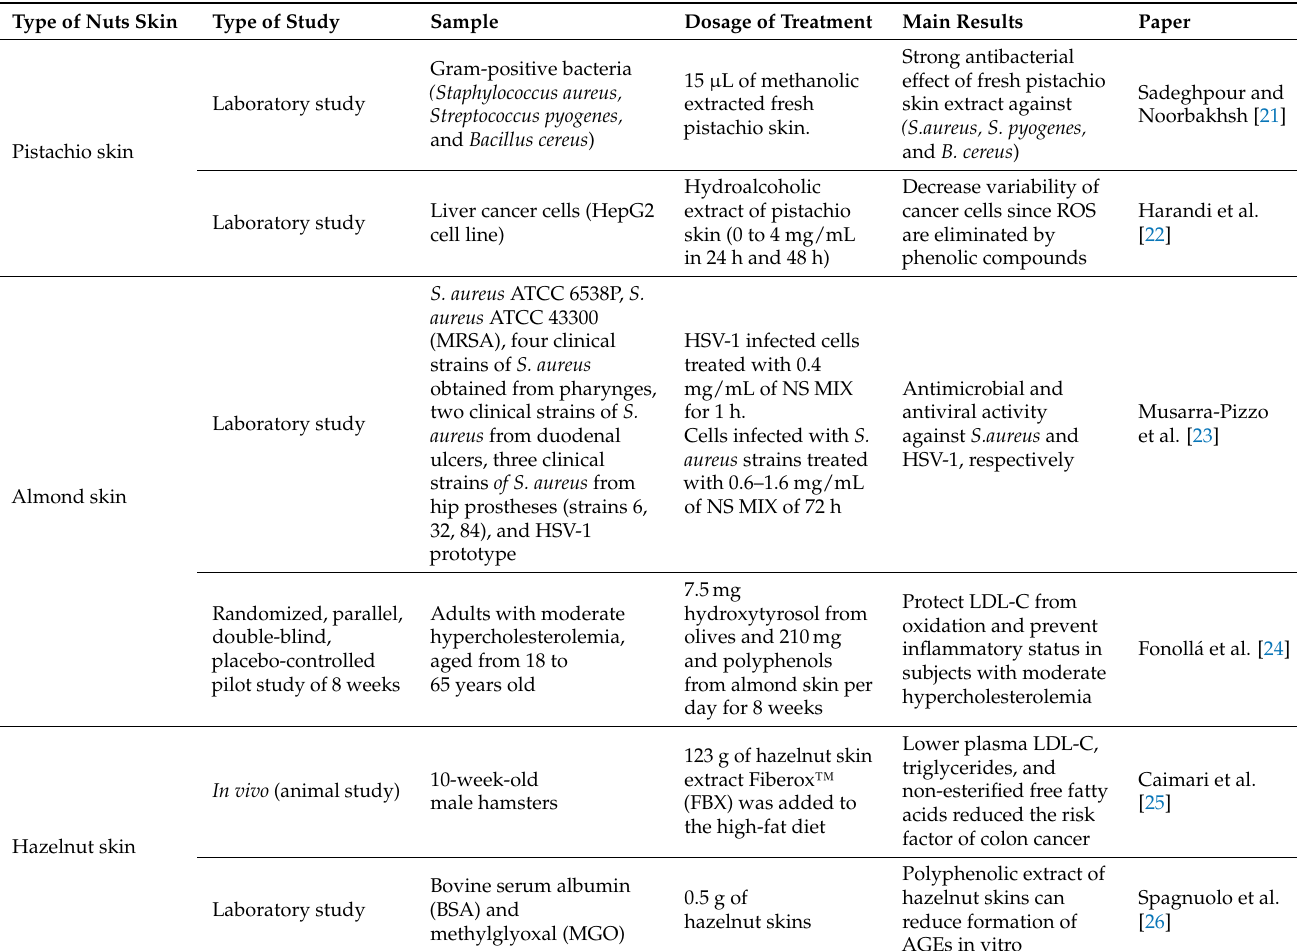
Table 1. Studies on the effect of pistachio, almond, and hazelnut skin in health